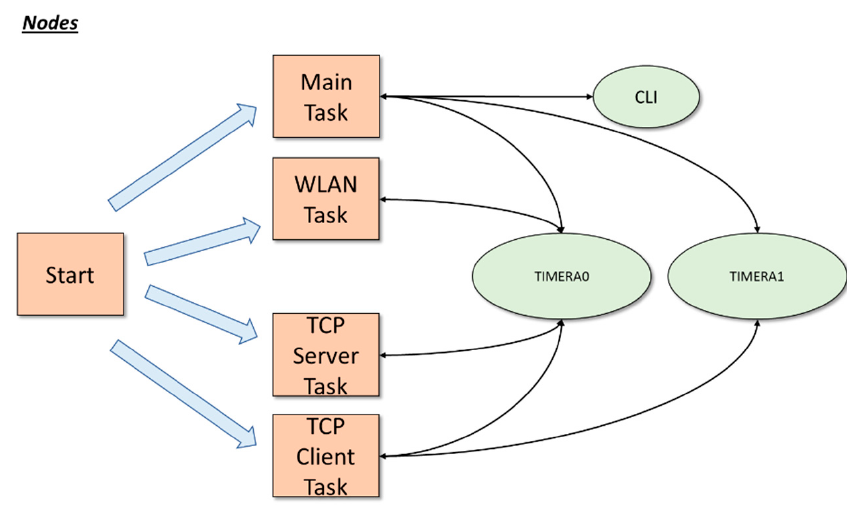
Figure 2. Block diagram of the Nodes software. The main functions (square blocks) and interrupts (oval blocks) are shown and their relationship.